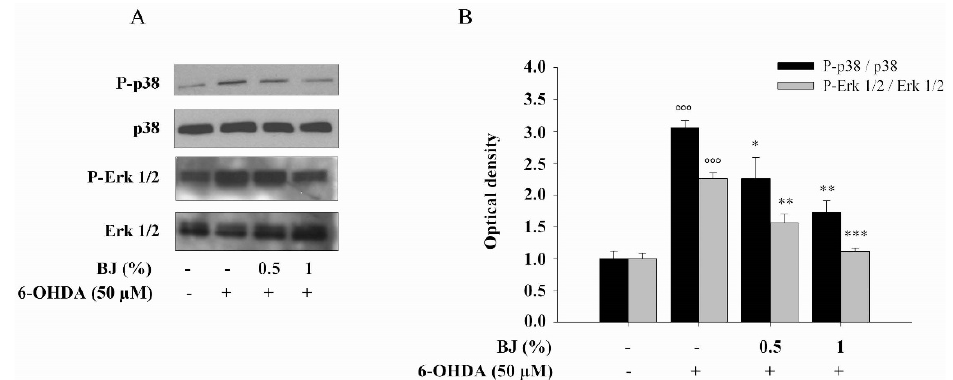
Figure 6. BJ reduces the phosphorylation of mitogen-activated protein kinases (MAPKs) induced by 6-OHDA. 6-OHDA induces the phosphorylation of Erk1 / 2 and p38 MAPKs in SH-SY5Y cells that was prevented by the pre-treatment with BJ. A representative immunoblot is depicted ( A ). The densitometric analysis of three separate blots (mean ± S.E.M.) is showed ( B ). Protein levels are extrapolated as values detected in control cells, which are arbitrarily assigned as 1. ◦◦◦ P < 0.001 vs. control; *, ** and *** P < 0.05, P < 0.01 and P < 0.001 vs. 6-OHDA-treated cells.